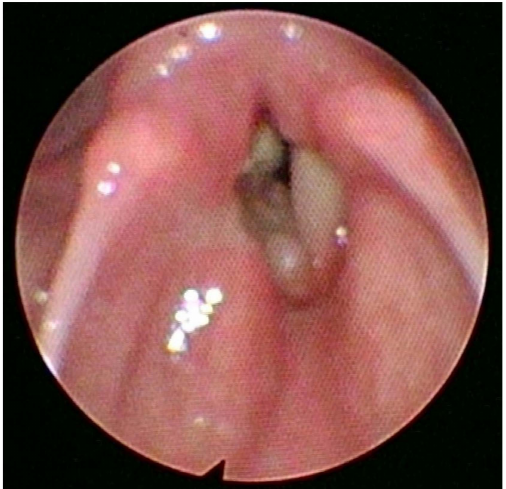
Figure 1. Endoscopic view of the larynx showing the lesion. The adenoid cystic carcinoma (ACC) arises from the minor salivary glands. It accounts for 1–5% of all head and neck malignancies. Since the minor salivary glands are present in small amounts throughout the larynx, the laryngeal adenoid cystic carcinoma is sporadic, representing less than 1% of all laryngeal malignancies [1]. Regarding the onset of laryngeal ACC (LACC), the prevalent age ranges from 50 to 60 years. However, younger generations can be affected, and both sexes are equally affected, with a slight male predominance and a male-to-female ratio of 1,5:1. There is no evidence connecting LACC etiology with smoking. An early perineural and hematological spread make this kind of carcinoma liable for local recurrence and distant metastasis, especially to the lung. Therefore, is important to increase the frequency of controls during follow-up [2]. Laryngeal ACC can originate from any part of the larynx. The most common origin is the subglottic area (64%), followed by the supraglottic area (25%), the glottic area (5%), and the trans-glottic area (6%) [3,4]. The clinical presentation is usually variable and related to the lesion location [5–7]. In November 2021, a 70-year-old no-smoker female patient presented to our hospital’s emergency department with stridor, severe dyspnea at rest, and hoarseness of voice. The O2 saturation level was 87% on air without cyanosis. An endoscopic laryngeal examination revealed bilateral vocal cord paralysis in adduction. Firstly, the patient underwent an urgent tracheostomy under general anesthesia. The procedure also included a laryngeal examination (micro-laryngeal surgery) under general anesthesia with tumor mapping, which revealed a bilateral mucosal thickening of the anterior thirds and anterior commissures of both vocal folds and a right vocal fold submucosal thickening (Figure 1). Multiple biopsies from different laryngeal areas were taken for histopathological examination. The pathological tissue revealed the presence of an adenoid cystic carcinoma of the solid type associated with the immunophenotype CK AE1 AE3 +, CD117+, CK7+/ − , p63 +/ − , p40+/ − , Vimentin +/ − , SMA+/ − , S100+/ − . Then, the patient underwent a CT scan of the neck chest and brain with a contrast medium and an abdominal ultrasound examination. The first chest, brain, and abdominal radiological evaluations did not show metastatic lesions. The neck CT scan revealed the presence of small submucosal bilateral glottic masses, associated with increased cervical lymph nodes volume, without subglottic and extra-laryngeal extensions (Figure